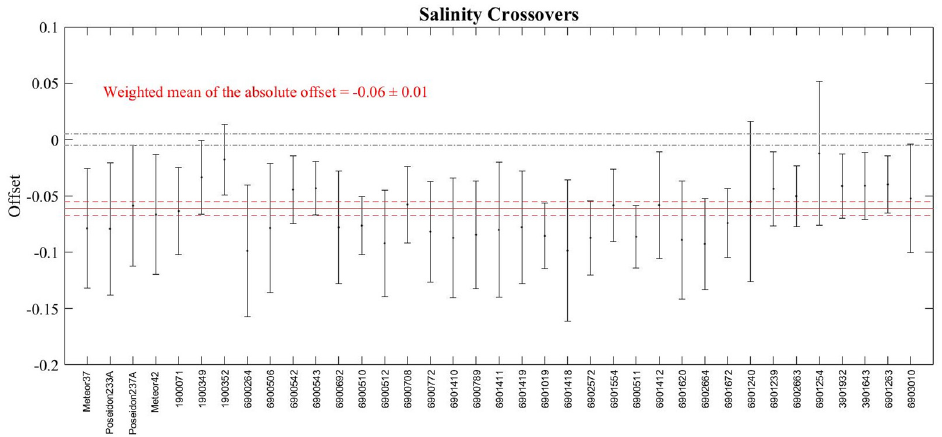
Figure 5. Salinity crossover analysis results. The data measured by the glider were compared with oceanographic cruises and historical ARGO data from the study area. The solid red line shows the weighted mean of the offsets with its standard deviation in dashed lines. The dashed gray lines show the predefined accuracy limits for this given parameter. The black dots and error bars show the weighted mean offset with respect to individual reference platform and their weighted standard deviation, respectively. The weighted mean and standard deviation of these offsets are noted as text in the figure.